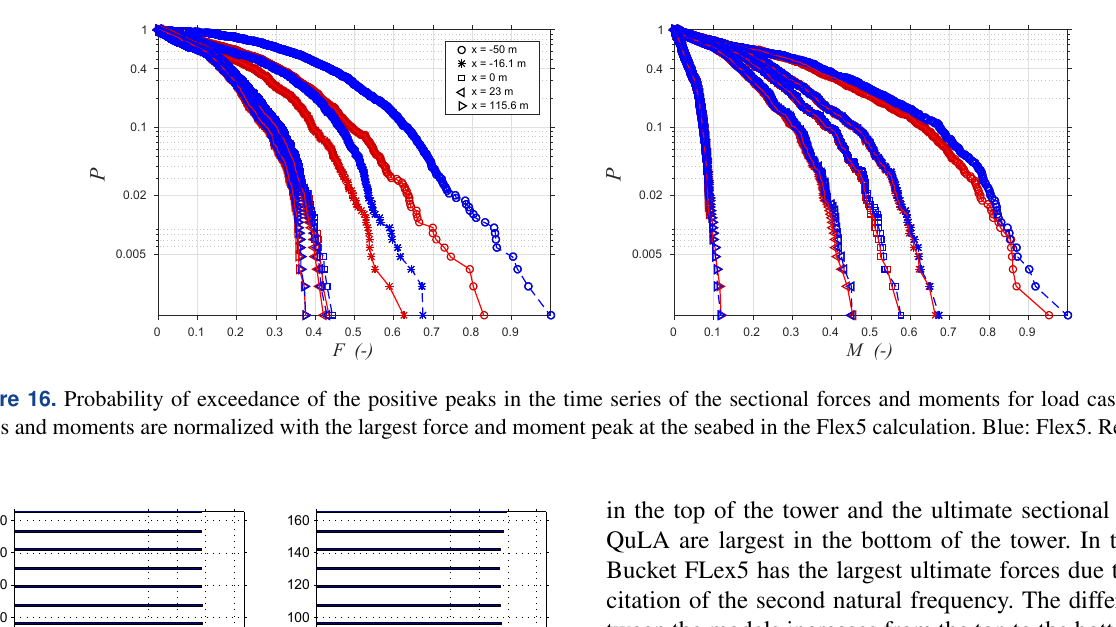
Figure 15. Sectional force at seabed for load case 1.2. The force time series are normalized with the largest force at the seabed in the Flex5 calculations.